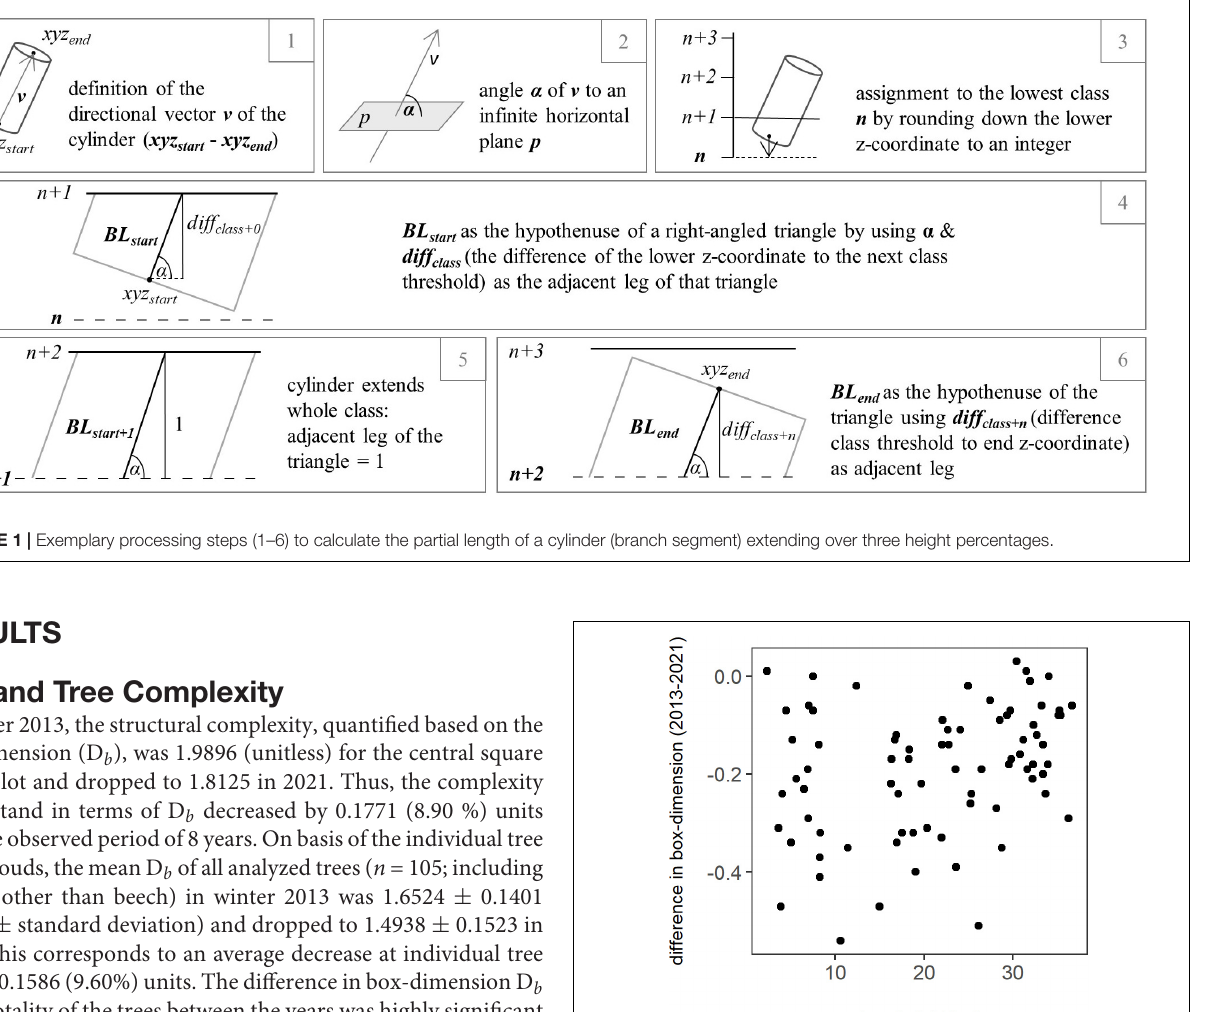
The effect is lowest for the top crown layer with a difference in mean D b of − 0.1386 corresponding to a relative difference of − 7.65% in relation to the D b of winter 2013, intermediate for the middle crown layer with a difference in mean of − 0.1694 (relative difference of − 10.06 %), and highest for the lowest crown layer, as shown by a difference in mean of − 0.2314 (relative difference of −